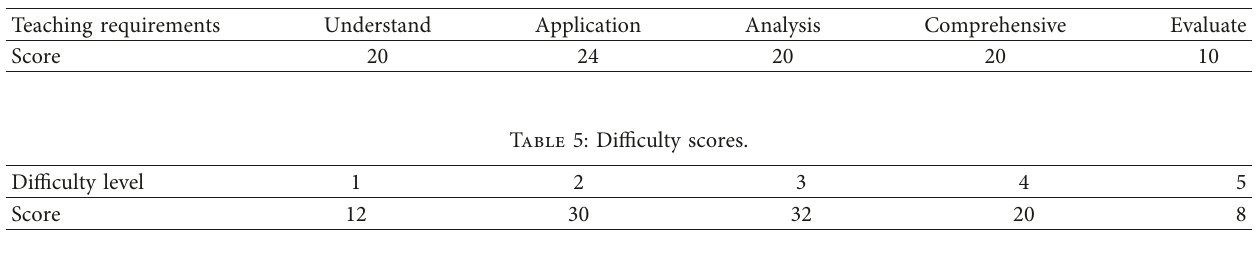
Table 4: Teaching practical requirements’ score.